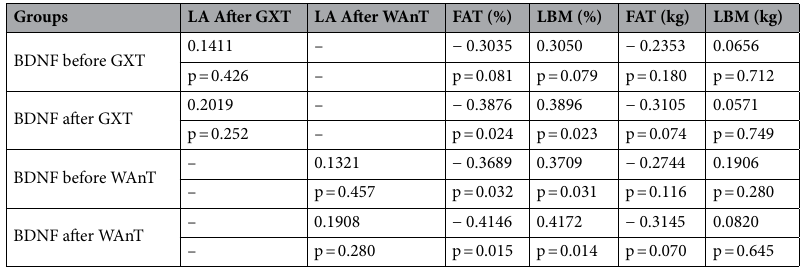
Table 4. BDNF correlation with LA and anthropological parameters at stage 0 (Person’s coefficient).